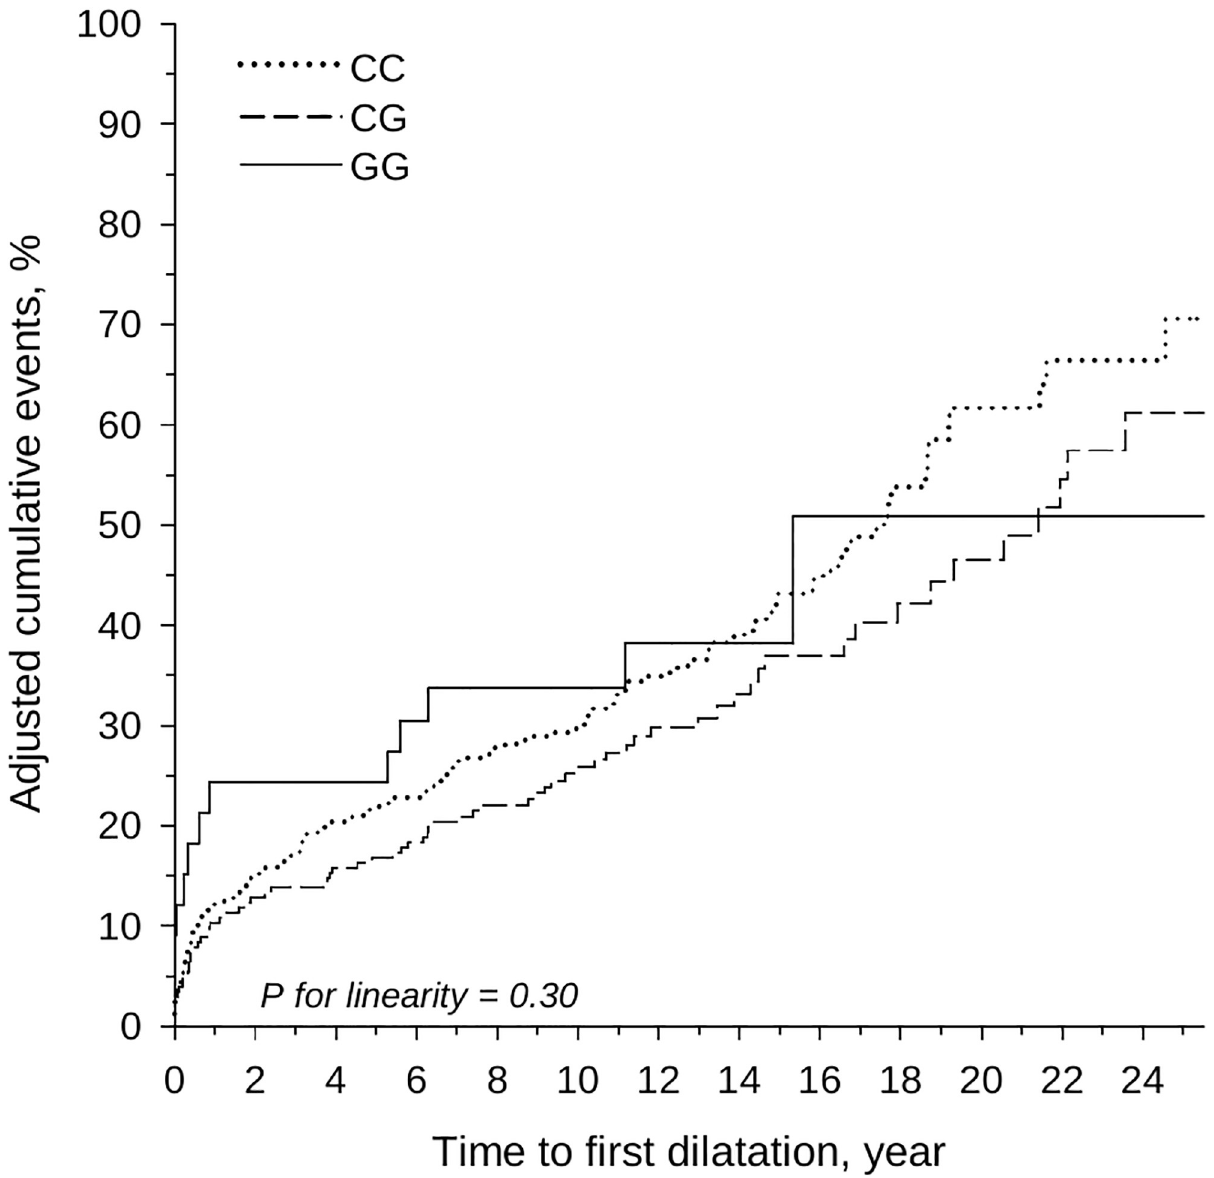
Fig 1. Impact of PNPLA3 haplotype on the development of strictures assessed by the time to first dilatation. Impact of the PNPLA3 haplotype; adjusted for sex and age at PSC diagnosis.